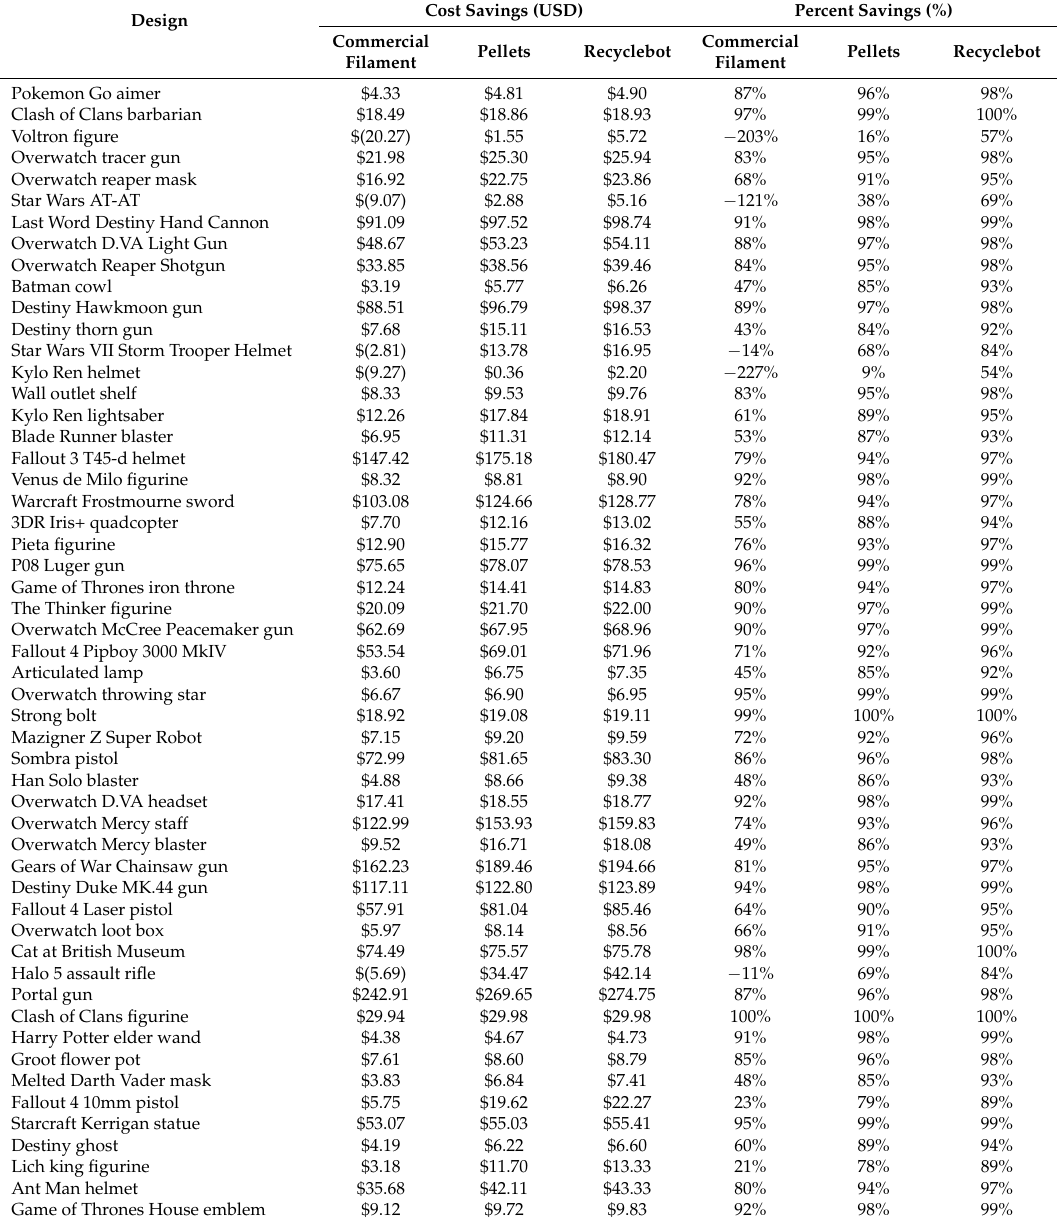
Table 3. Cost savings for individual toys (US$) and percent (%)